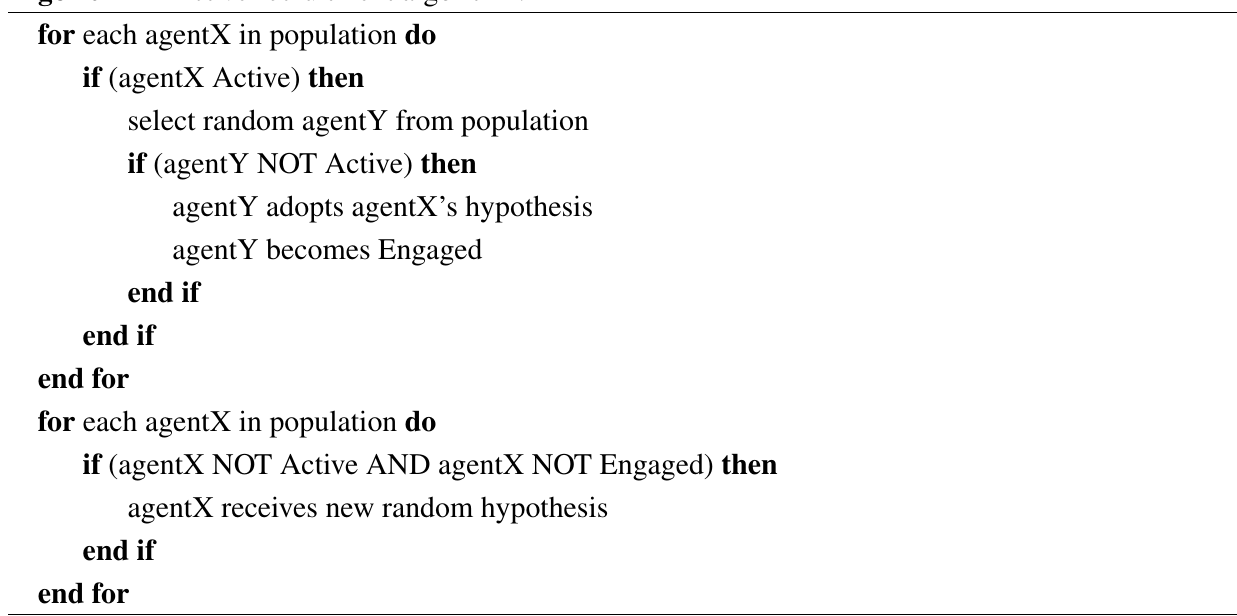
Algorithm 4 Active recruitment